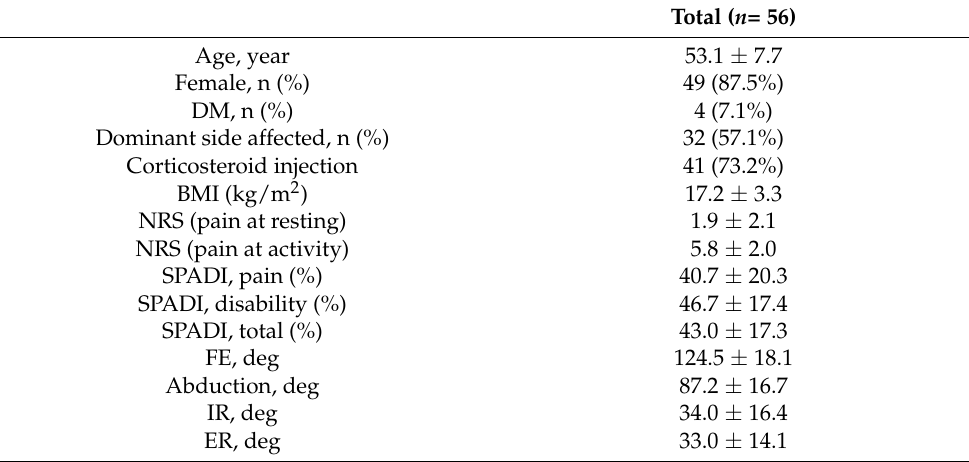
Table 1. Epidemiologic and clinical characteristics of the patients at baseline evaluation.